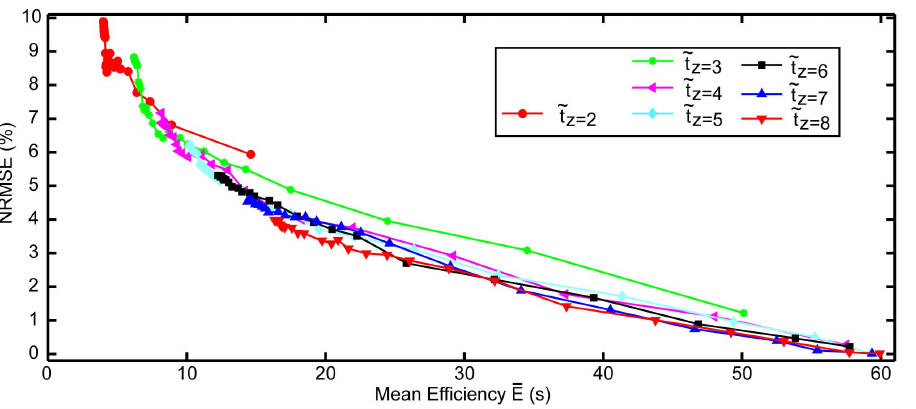
Figure 8. Plot of normalized root mean square error (NRMSE) against mean efficiency (cid:2) EE for different consistency thresholds Th C and different number of time intervals in a set (z). Increasing the accuracy (smaller NRMSE) is at the cost of increasing (cid:2) EE .